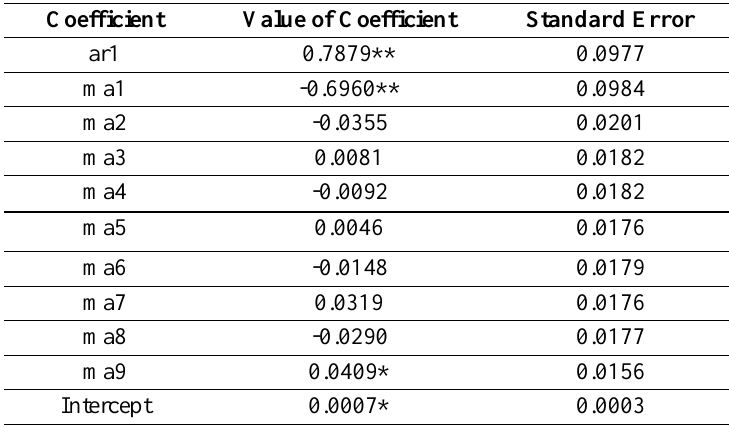
Table.1. Result of ARMA (1,9)